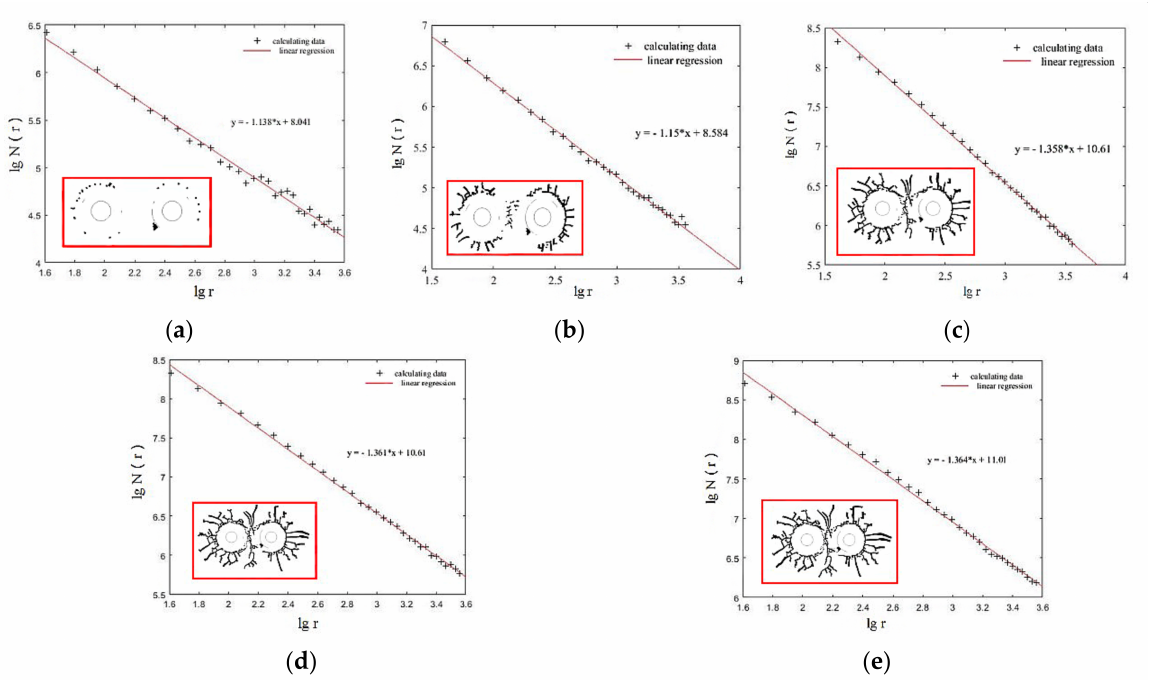
Figure 8. The 120 mm aperture, 840 mm aperture fractal dimension and damage evolution process. ( a ) At 1 us after explosion; ( b ) 2 us after explosion; ( c ) 3 us after explosion; ( d ) 4 us after explosion; ( e ) 5 us after